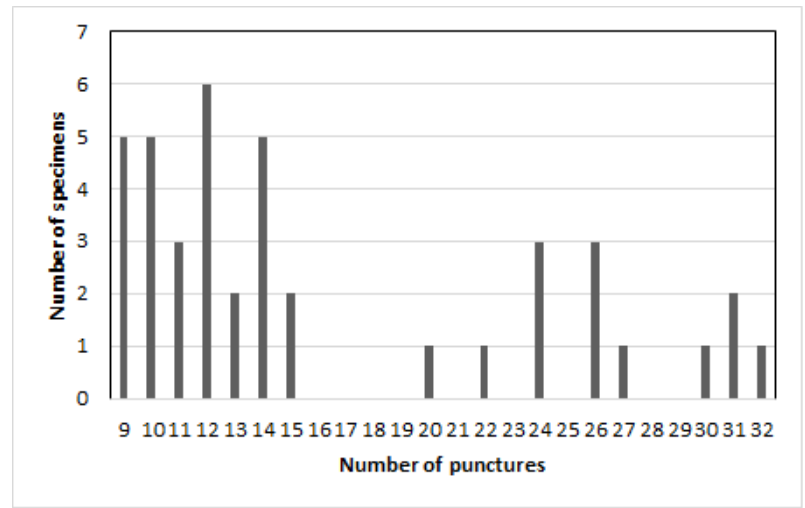
Figure 2. Chrysolina fascinatrix , number of punctures in 5th elytral row. 3.2.2. Diameter of Puncture in 5th Elytral Row near Mid-Length The diameter of punctures varies by almost five times from about 0.02 to 0.1 mm with a predominance of average values (Figure 3). Difference between females and males is not found. Figure 3. Chrysolina fascinatrix , diameter of punctures in 5th elytral row. 3.2.3. Length of Aedeagus in Lateral View The length of the aedeagus varies considerably from 1.5 to 2.1 mm with a predomi- nance of average values (Figures 4 and 5). However, the relative length remains approxi- mately the same, about 0.3 X of the body length.